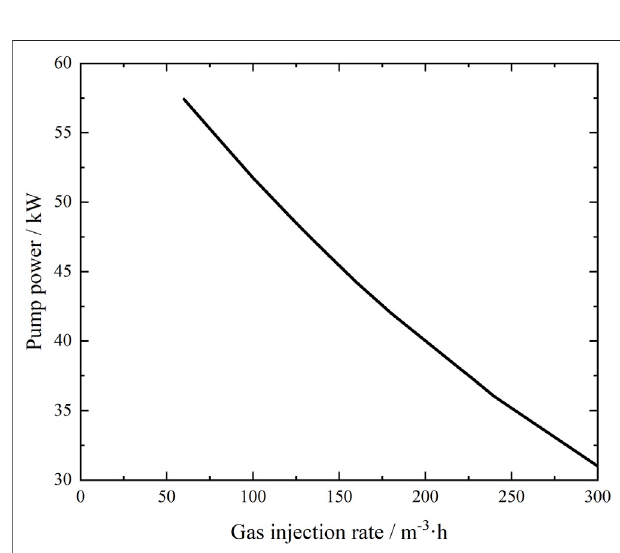
FIGURE 9 | Effect of gas injection displacement on gas volume fraction in the return pipeline.